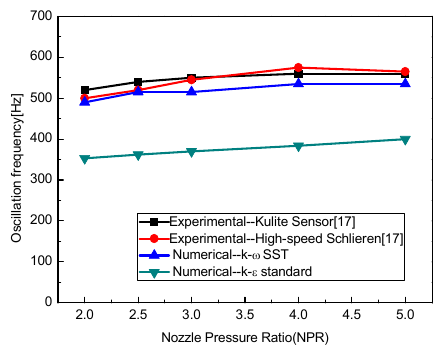
Figure 4. Effects of NPR on frequency.